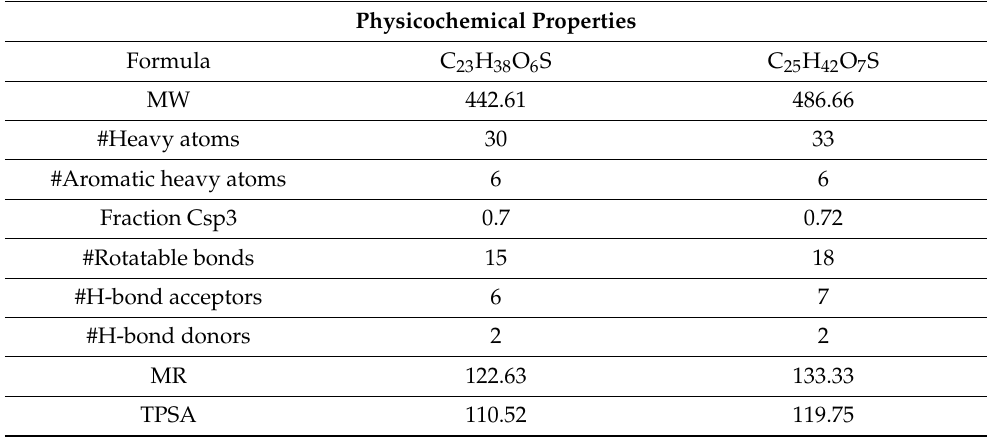
Figure 9. Boiled egg predictive model of MPAO. Table 3. Predicted absorption, distribution, metabolism, excretion, and toxicity (ADMET) properties from computational analysis.